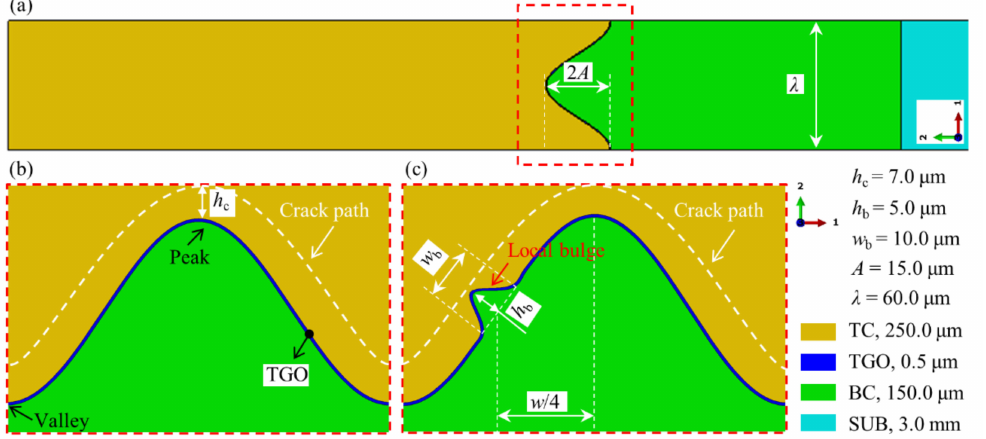
Figure 2. Geometric model of APS TBC: ( a ) overall model, ( b ) the TC/BC interface without bulge, and ( c ) the TC/BC interface with one bulge.